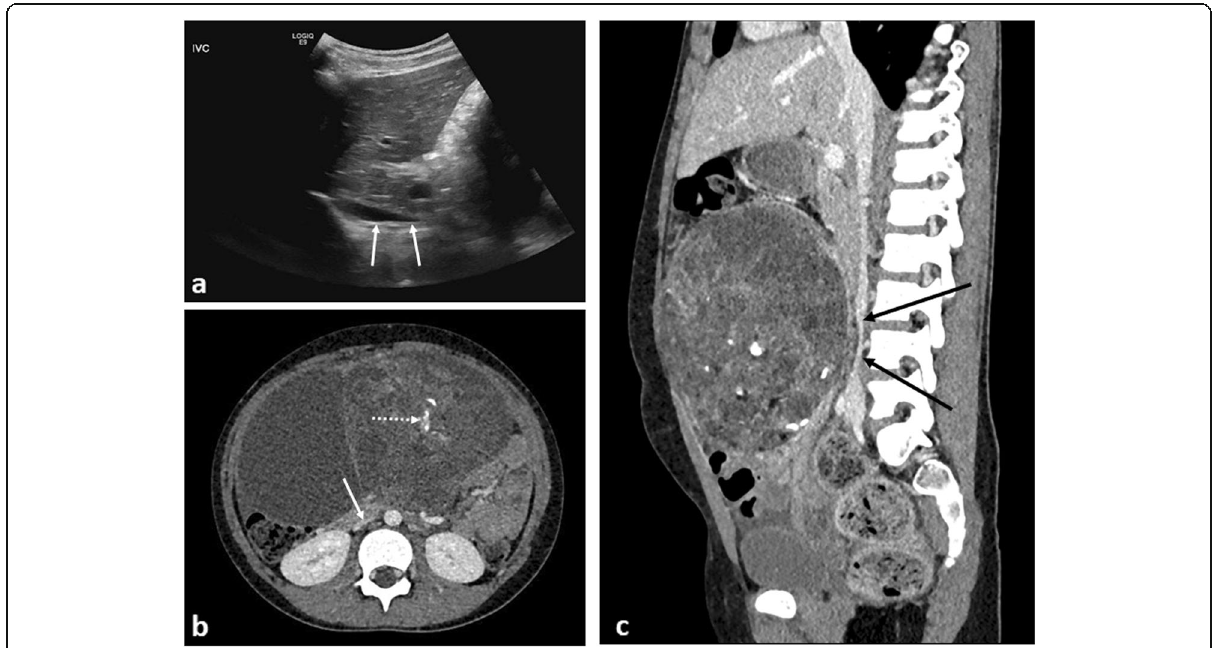
Fig. 12 An 8-year-old girl with increasing abdominal distension secondary to a malignant germ cell tumour (MGCT). a A sagittal abdominal ultrasound image demonstrates tapering of the upper abdominal inferior vena cava (IVC) (white arrows). b Axial contrast-enhanced CT image at the level of the kidneys demonstrates flattening of the IVC (arrow). There is also a large heterogenous mass in the anterior abdomen containing internal foci of calcification (dashed arrow). c Sagittal CT image of the IVC reveals demonstrates compression of the vessel (black arrows), again placing the patient at risk of poor central venous return